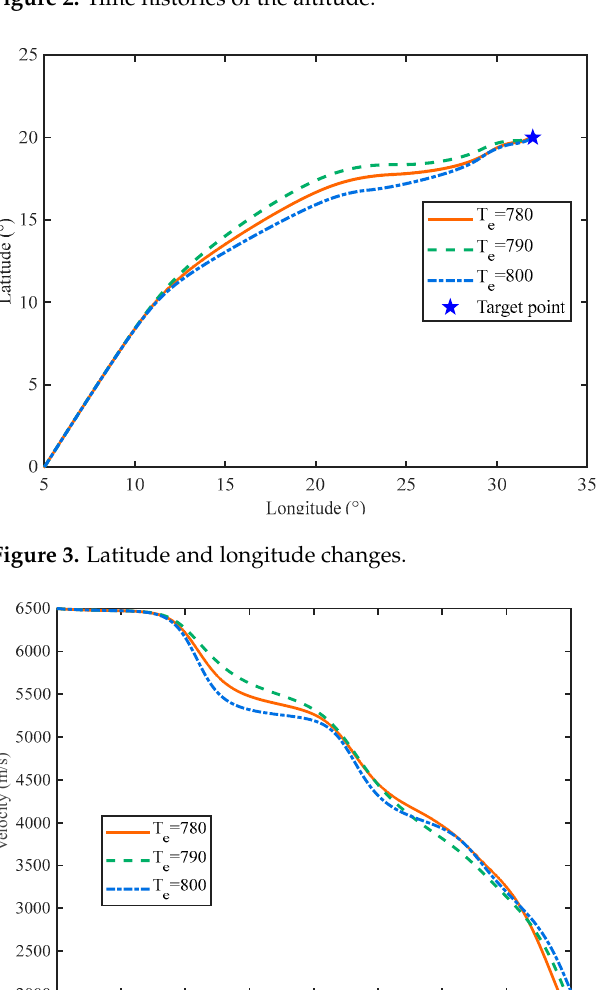
Figure 2. Time histories of the altitude.